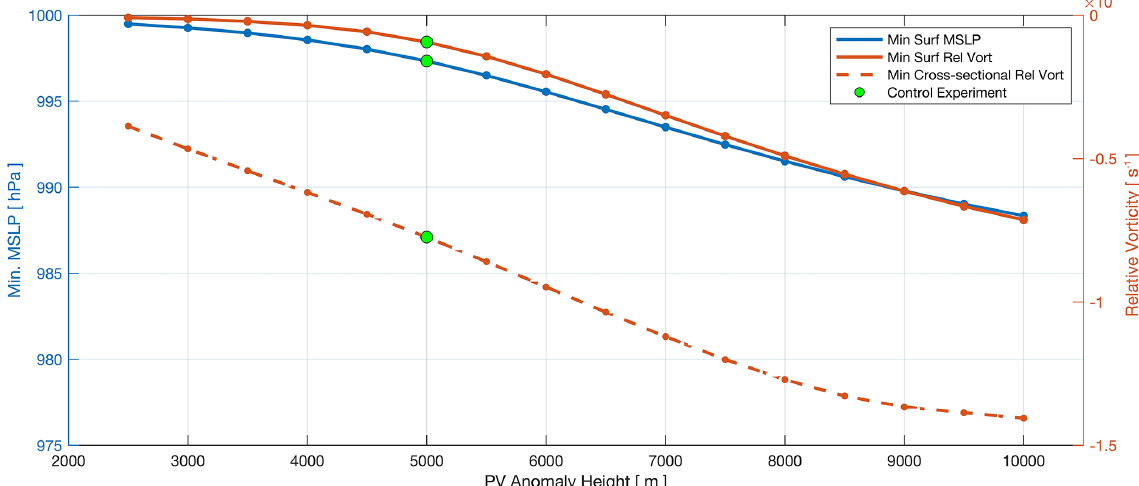
Figure 8. Changes to surface parameters (solid lines) as a function of anomaly radial height (depth of intrusion). The minimum mean sea level pressure (MSLP) (blue) and relative vorticity (orange) on the surface pressure level are recorded and plotted. The cross-sectional minimum relative vorticity as a function of anomaly depth is also shown by the dashed line. The results in Experiment 0 are highlighted in green for